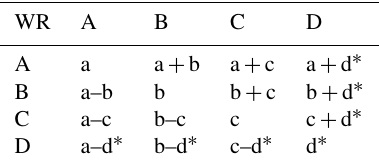
Table 1. Definition of WRs and WR combinations. WR combi- nations are defined as either additions or subtractions of monthly WR frequencies. Asterisks indicate regimes that exist only in win- ter and spring when four WRs are